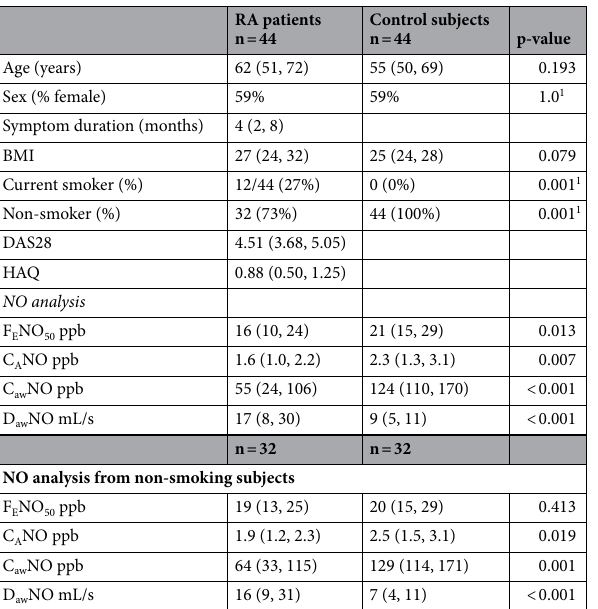
Table 1. Characteristics of patients and control subjects in Protocol A. Data given in median (lower and upper quartiles). 1 Pearson Chi-square analysis. BMI, body mass index; DAS28, disease activity score for 28 joints; HAQ, the Swedish version of the Stanford Health Assessment Questionnaire; F E NO 50 , fraction of exhaled nitric oxide at the flow of 50 mL/s; C A NO, alveolar nitric oxide; C aw NO, nitric oxide content in the airway wall; D aw NO, nitric oxide diffusion capacity over airway